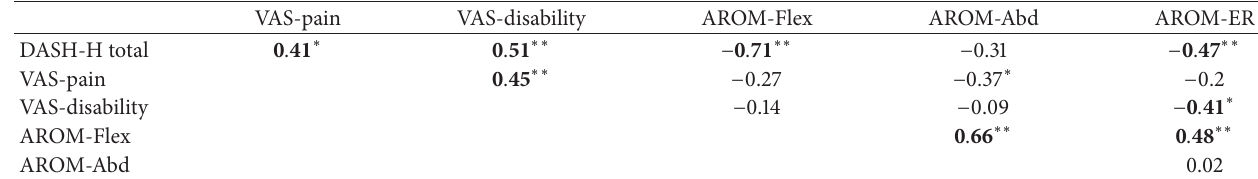
Table 3: Correlation between the measures ( 𝑁 = 30).